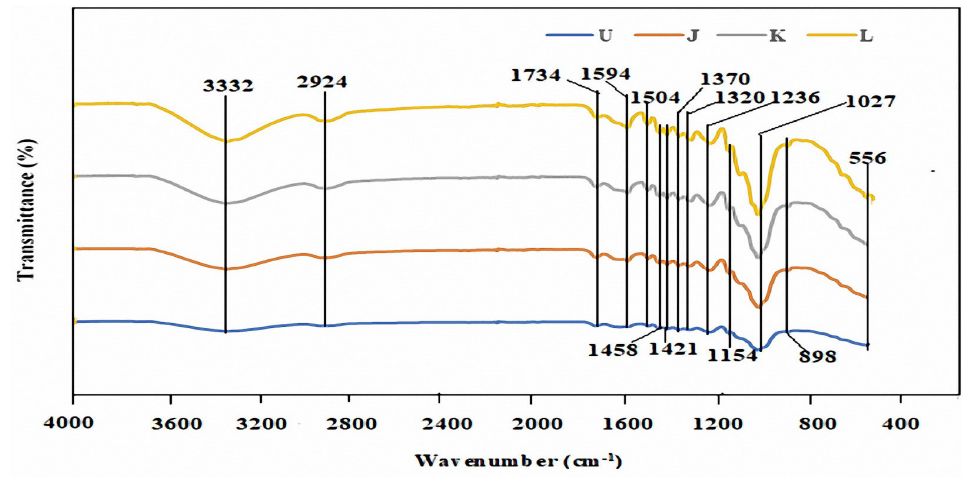
Figure 3. FTIR spectra of untreated and hydrothermally treated rubberwood, ( U ) control, ( J ) 160 °C, pH 8 ( K ) 180 °C, pH 8, and ( L ) 200 °C, pH 8. Peaks at 3332 cm −1 , 2924 cm −1 , 1734 cm −1 , 1594 cm −1 , 1504 cm −1 , 1458 cm −1 , 1320~1421